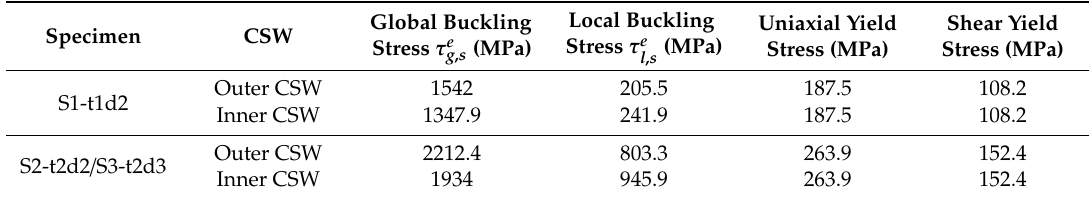
Table 14. Shear Buckling Stress of CSWs.